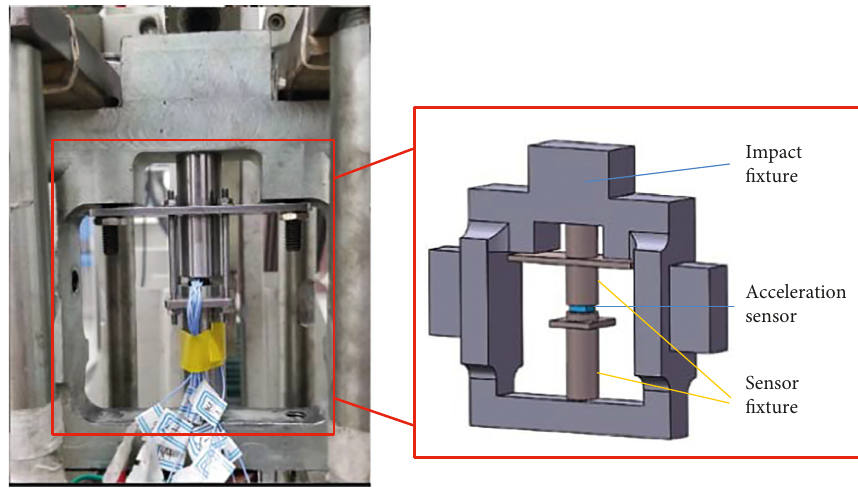
Figure 12: Sensor fixture and assembly relationship.